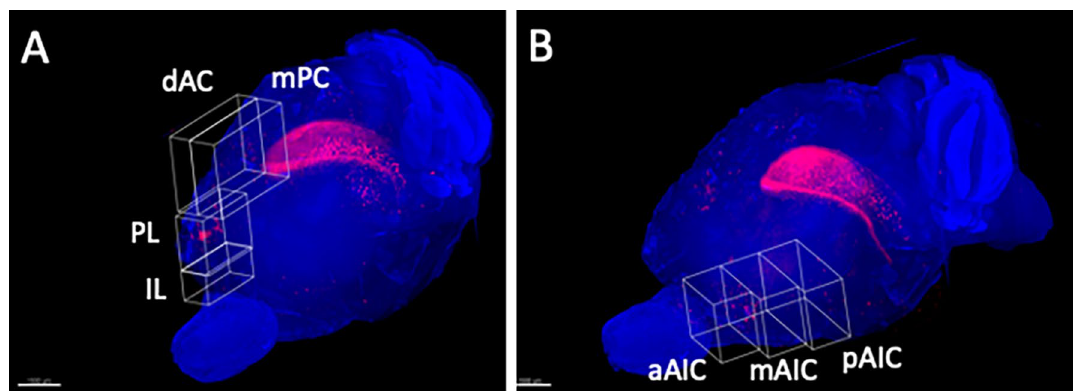
Figure 11. 3D ROI settings in mPFC and AIC. ( A ) 3D ROI setting in the medial prefrontal cortex (mPFC). The mPFC in rodents is anatomically and functionally divided into four subdivisions from dorsal to ventral: the medial precentral cortex (mPC), dorsal anterior cingulate cortex (dAC), prelimbic cortex (PL), and inflalimbic cortex (IL). 3D ROIs were set in these four regions. ( B ) 3D ROI setting in the agranular insular cortex (AIC). The AIC is divided into three subregions, from rostral to caudal (anterior [aAIC], middle [mAIC], and posterior [pAIC]). 3D ROIs were set in these three regions. Only the left hemisphere is shown because showing both hemispheres would interfere with clarity due to image